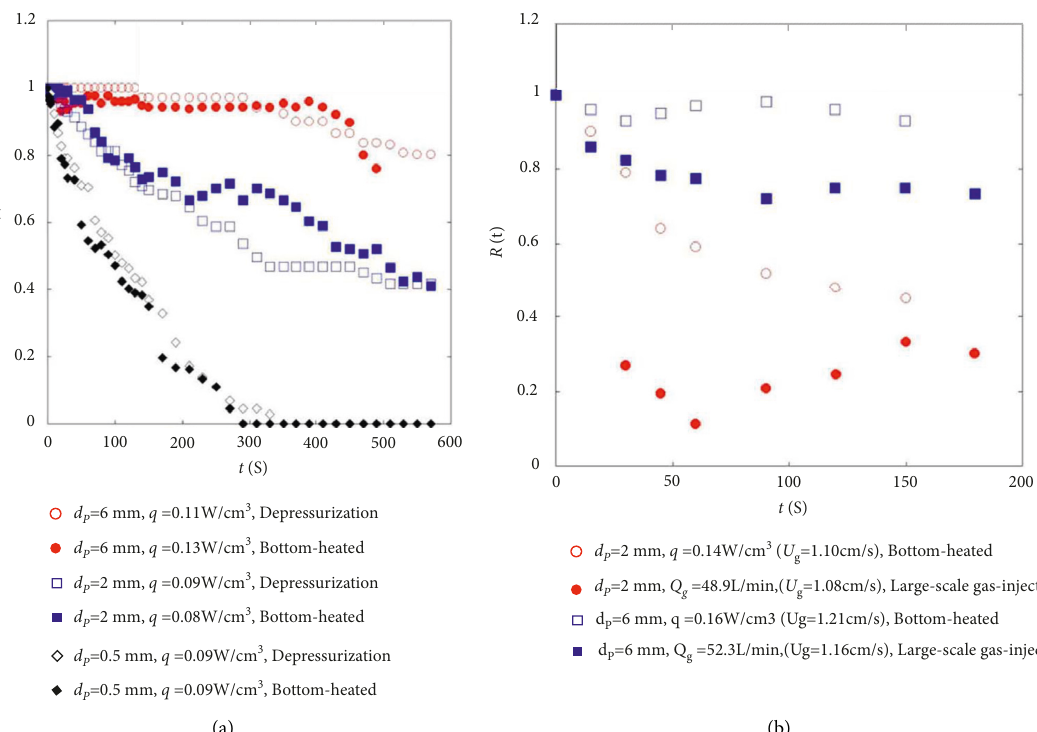
Figure 11: Effect of bubbling methods on R (t) (water depth � 400mm, spherical alumina particles) [10, 32, 36] (a) Depressurization and bottom-heated methods (b) Gas-injection bottom-heated